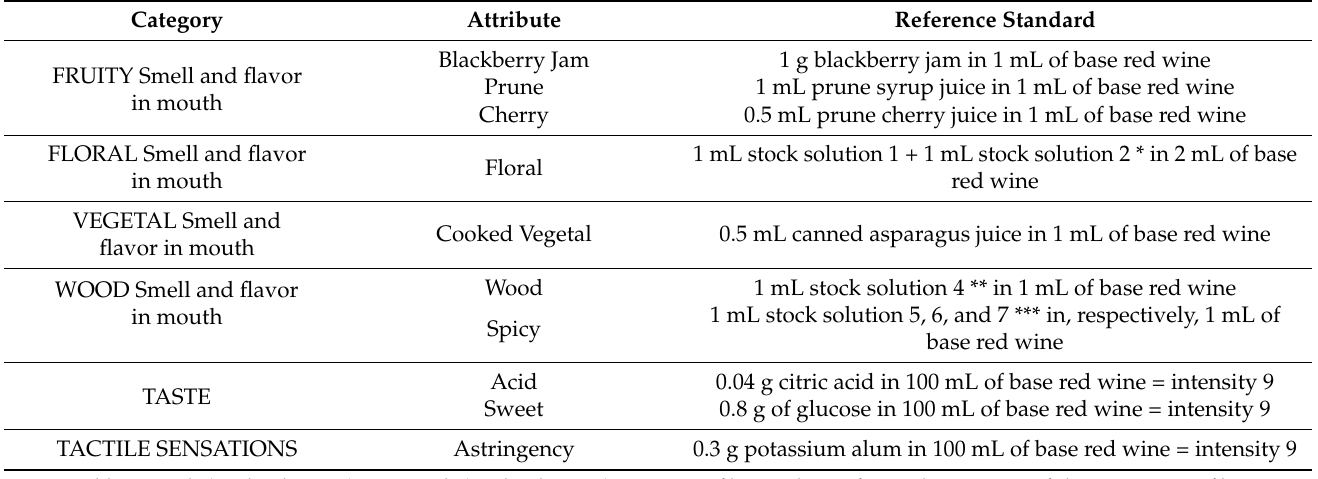
Table 2. Attributes and Reference Standard for the panel